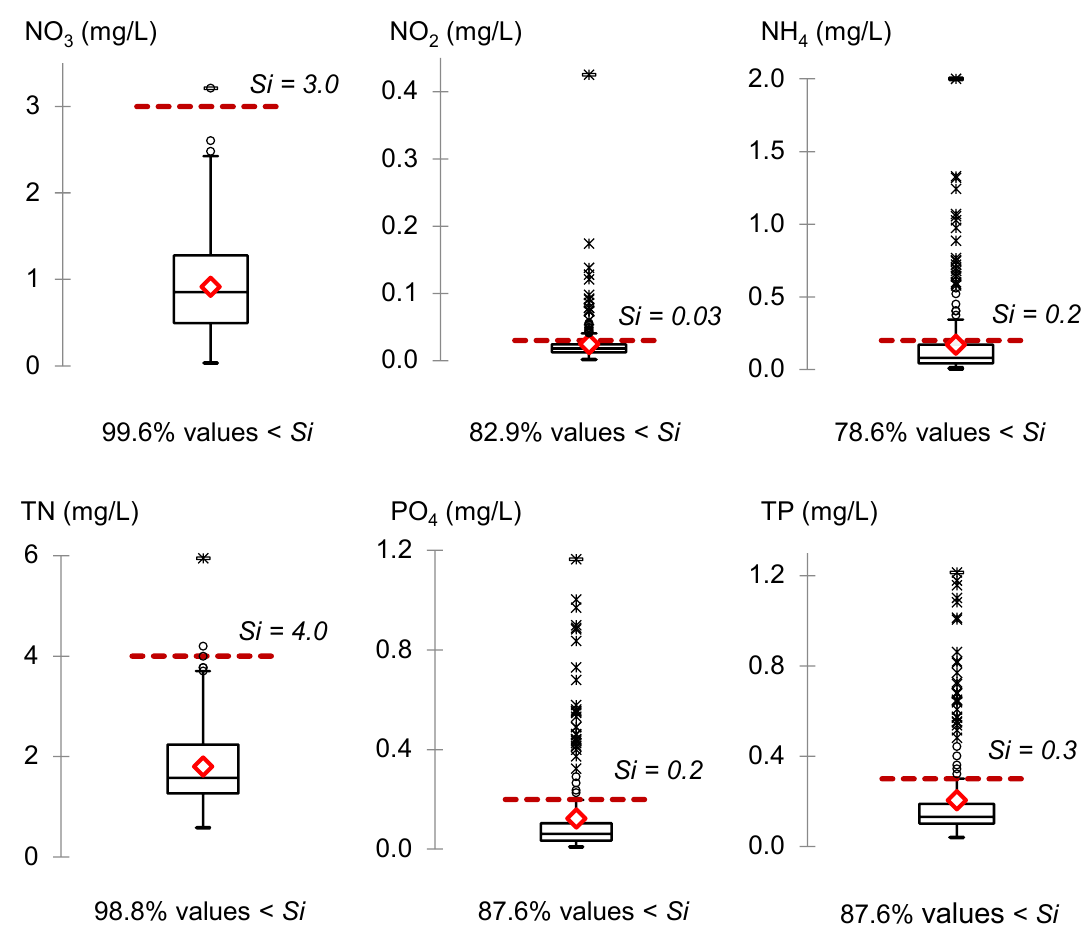
Figure 2. Box plots of average monthly N and P concentrations (red square) in examined water samples for the period 2000–2019 in relation to limit value ( Si, red dashed line) for the class of good environmental status.